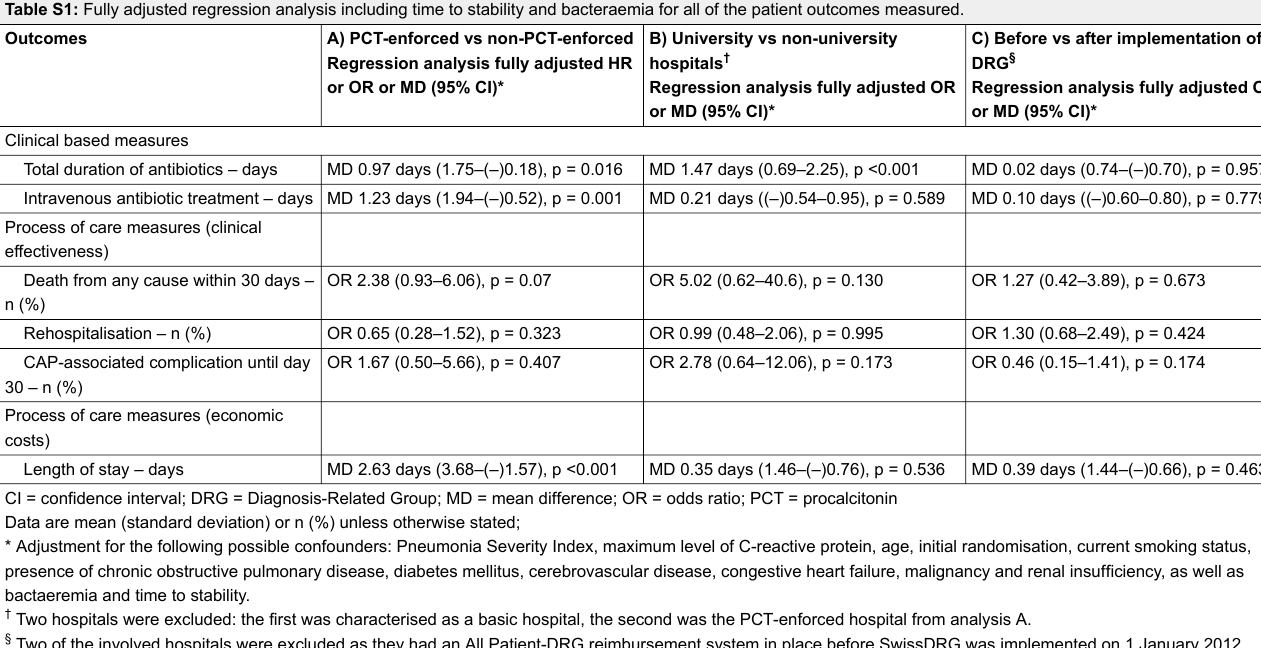
Table S1: Fully adjusted regression analysis including time to stability and bacteraemia for all of the patient outcomes measured.